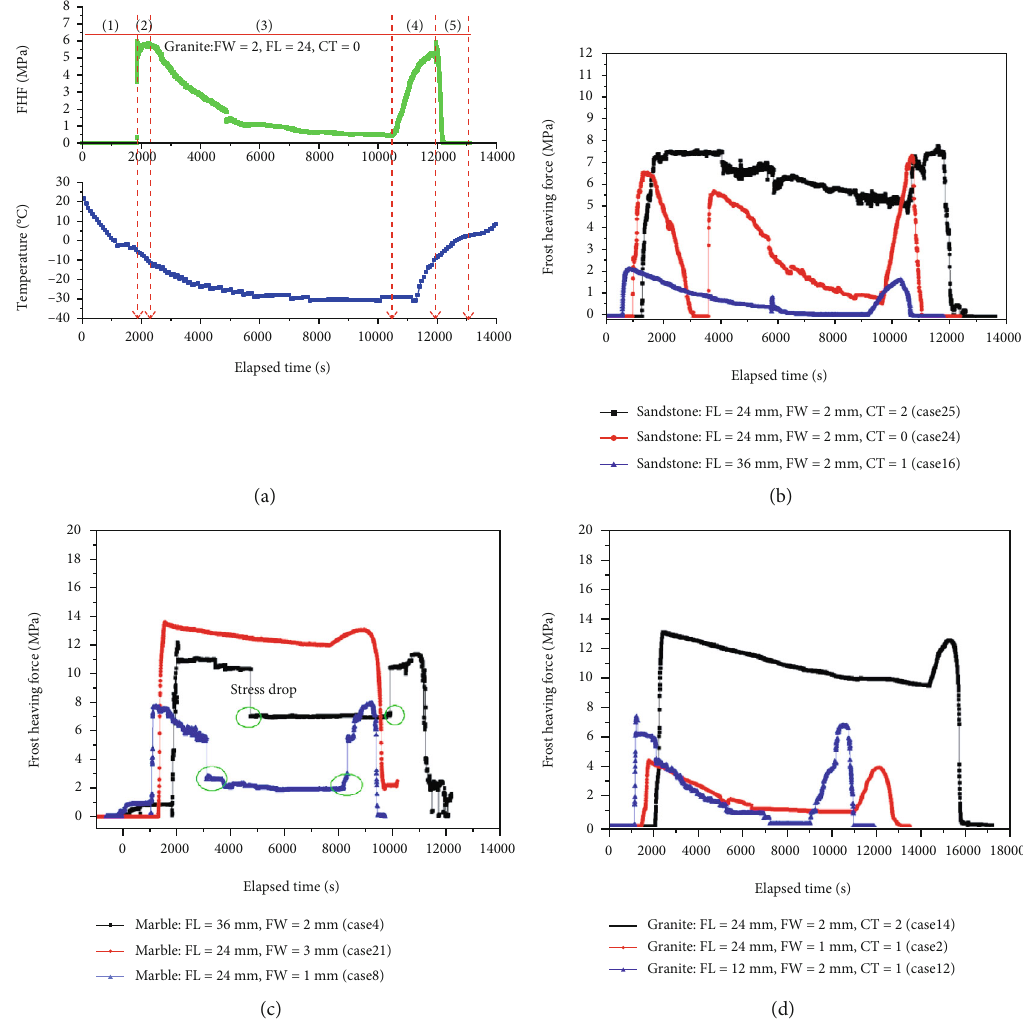
Figure 5: Evolution of frost heaving force for typical experimental cases. (a) Evolution stages division, taking case 6 for example. (b) Frost heaving force curves for typical marble samples. (d) Frost heaving force curves for typical granite